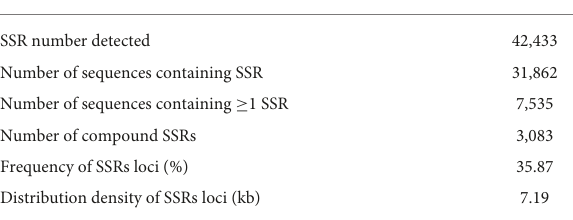
TABLE 1 General information for the SSR